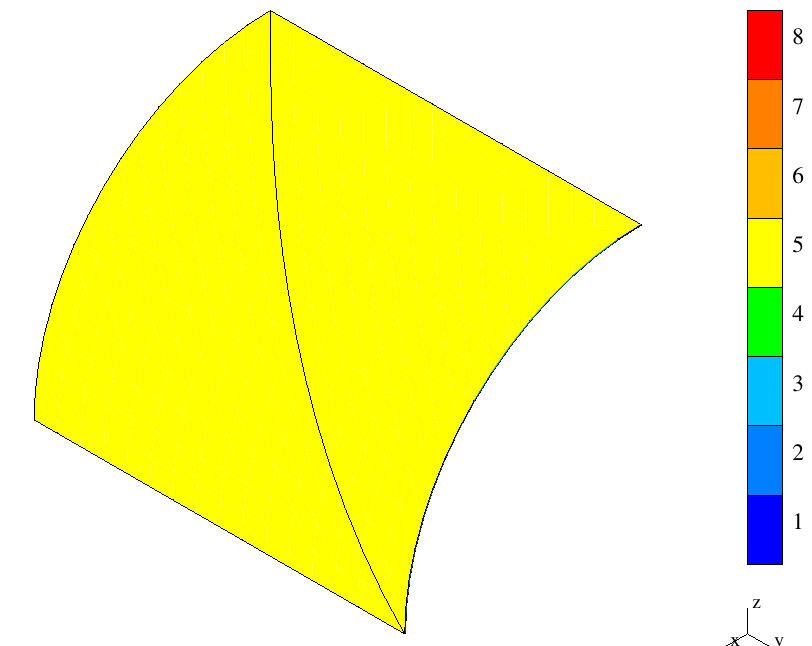
Figure 24. A quarter of a bending-dominated shell—mesh after optimized